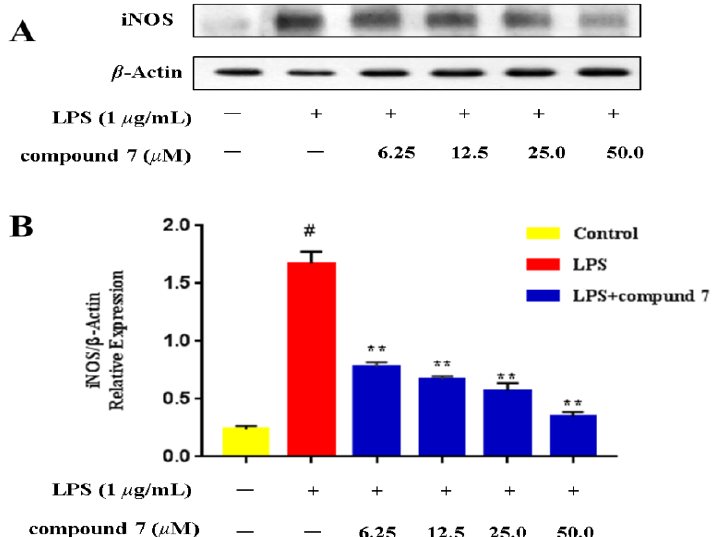
Figure 4. Concentration dependency of the inhibitory effects of compound 7 on iNOS enzyme. ( A ) Typical blotting of iNOS and β -actin. ( B ) The bar chart shows the quantitative evaluation of iNOS bands by densitometry. Data represent the mean ± SD ( n = 3). ** p ≤ 0.01 compared with LPS-treated control. # LPS-treated control.